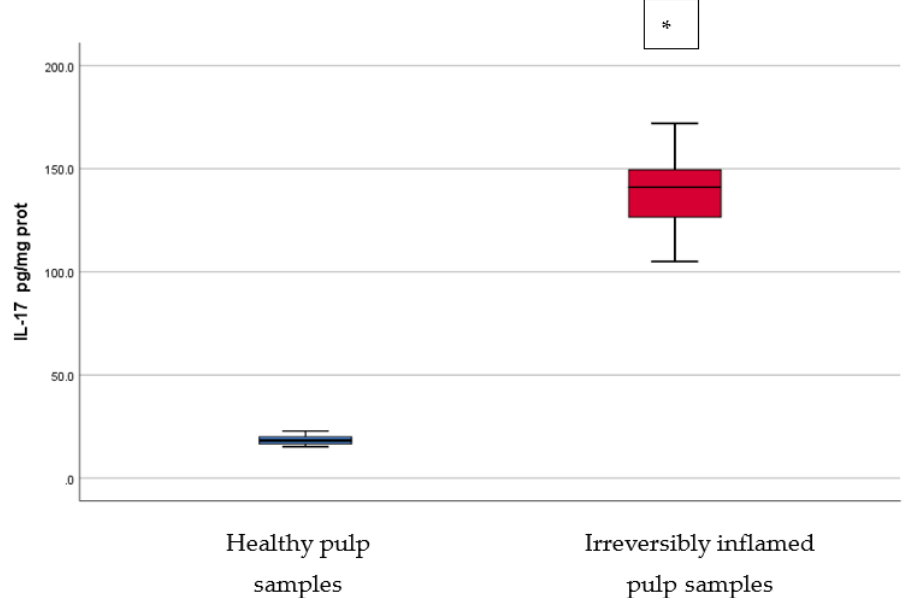
Figure 2. Comparison of IL-17 levels (pg/mg protein) in healthy and irreversibly inflamed dental pulp samples, respectively. The distribution of variables is parametric in both groups according to the Shapiro–Wilk test ( p > 0.05). Welch’s t -test shows that the differences between the two groups are statistically significant ( p < 0.001). (* indicates a statistically significant difference).